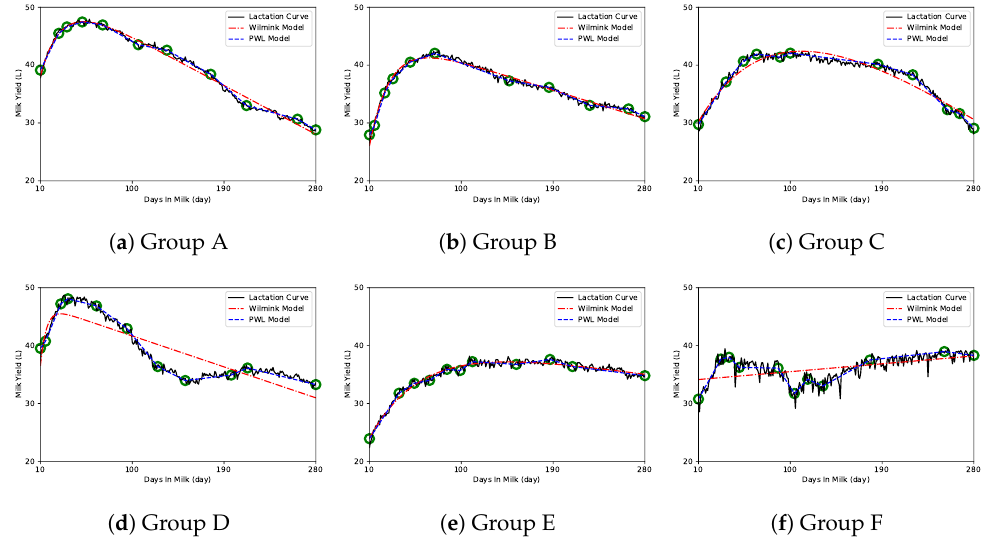
Figure 6. Fitting results of the PWLR model for the